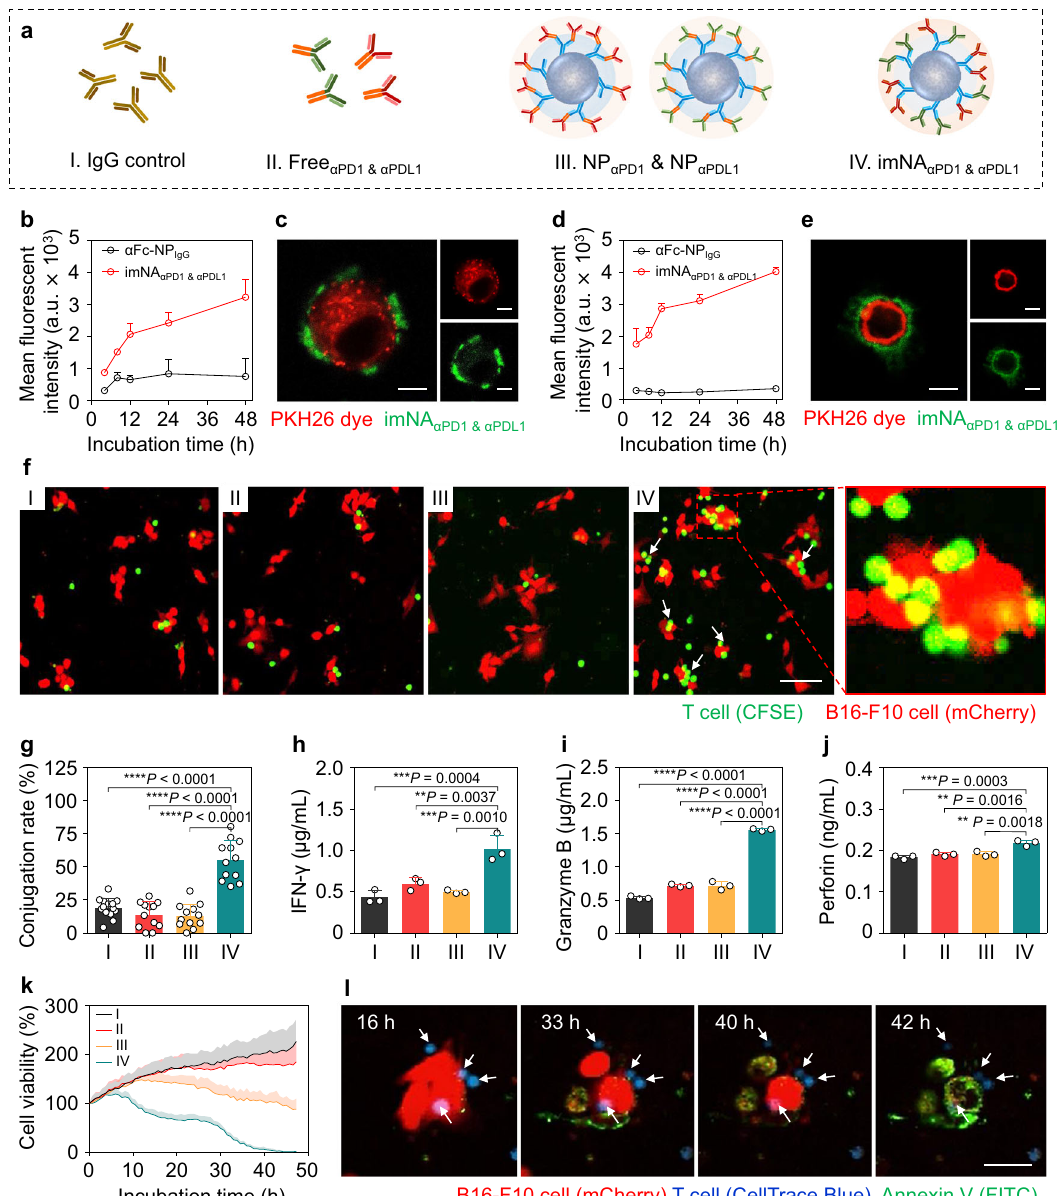
Fig. 3 imNA α PD1 & α PDL1 increases CD8 + T cell-mediated cytotoxicity in vitro. a CD8 + T cell-mediated antitumor immunity was selected as a model